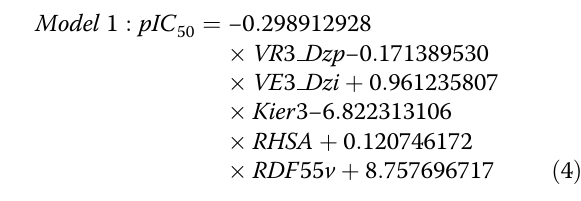
Table 2. The regression equations of the other QSAR models built are presented in Supplementary Table S1. Table 3 presents the correlation between the molecular descriptors in the model as well as their VIF and mean effect values. The external validation of the model was investigated by subjecting the model to the test set. The external coefficient of determination ( R 2 ) was calcu- ext. lated as presented in Table